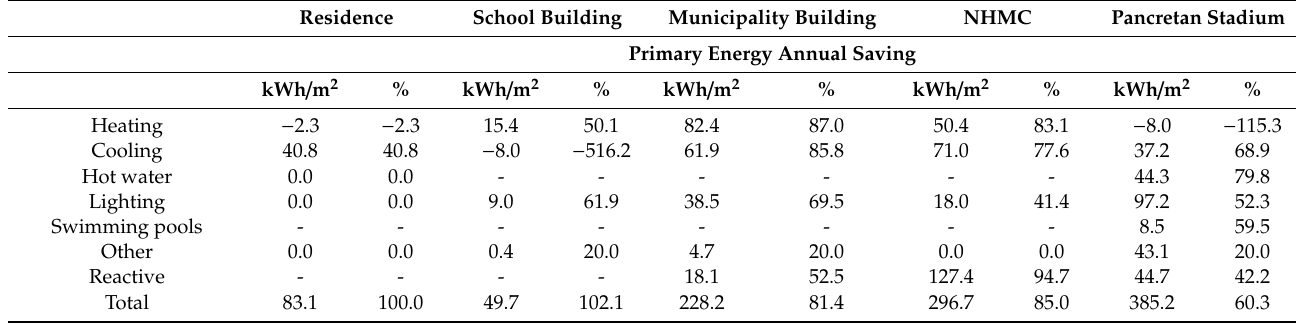
Table 9. Primary energy annual achieved savings in the examined buildings with the introduction of all the proposed passive and active